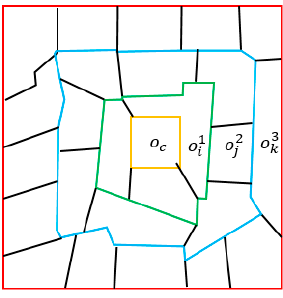
Figure 1. Demonstration of the center node and its neighbors with different spatial distances. The center node is (cid:1867) (cid:3030) . (cid:1867) (cid:3036)(cid:2869) , (cid:1867) (cid:3037)(cid:2870) and (cid:1867) (cid:3038)(cid:2871) represent the neighboring nodes with spatial distances of 1, 2, and 3, respectively.